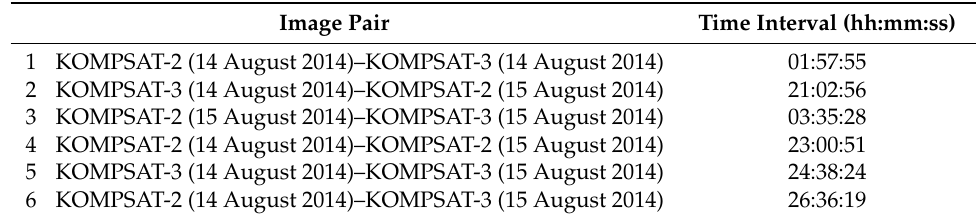
Table 4. Combinations of image pair for measuring and validating sea ice motion. Image